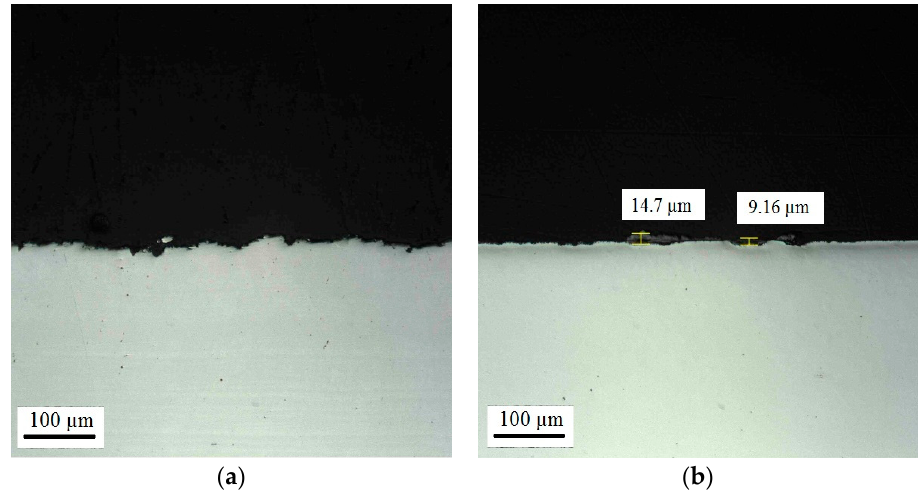
Figure 5. Microstructure images of the cross-section of 316-Bare ( a ) before, and ( b ) after the high-temperature corrosive attack after 168 h.